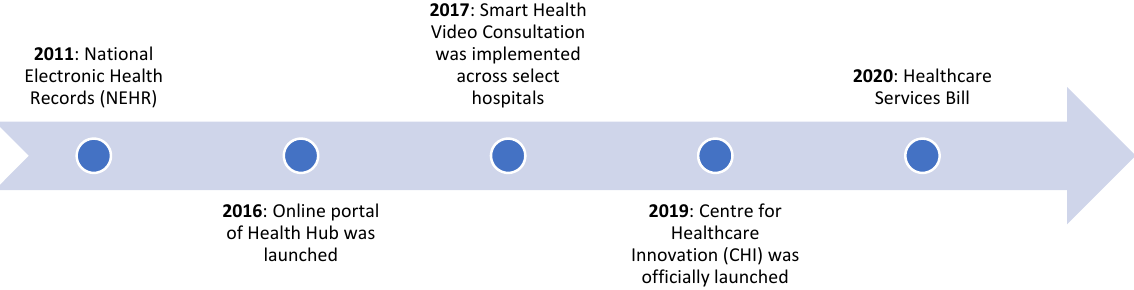
Figure 3. Policy trajectory from cloud adoption to public health innovation in Singapore.